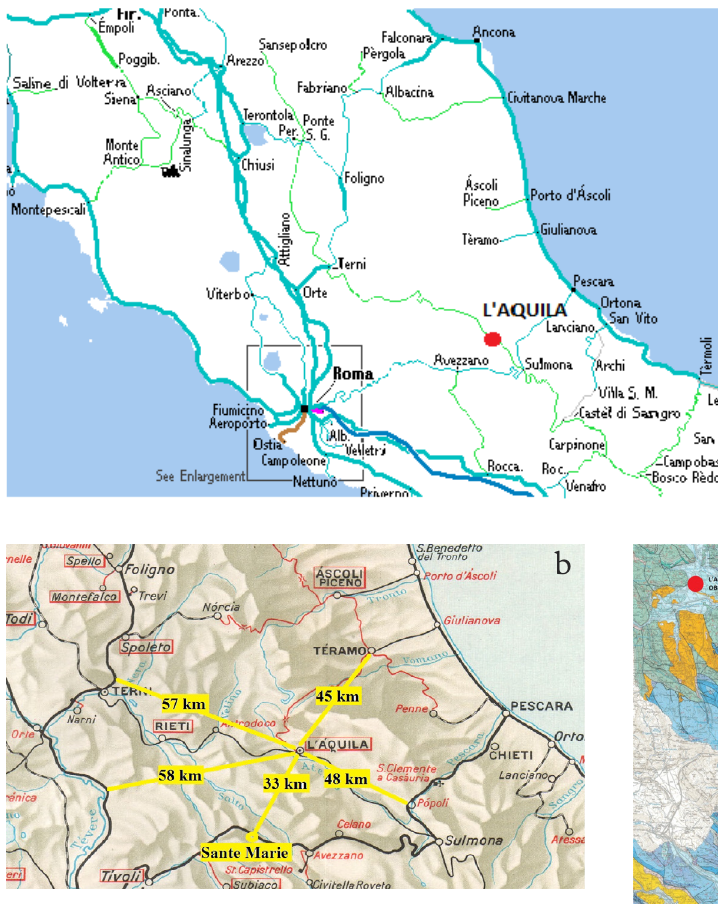
Figure 3. (a) Railway map of Central Italy. The DC electrified rail- way line that mainly interferes with L’Aquila Geomagnetic Obser- vatory is Roma-Sulmona-Pescara in light blue colour; at the contrary the Terni-L’Aquila-Sulmona line, in green, it does not dis- turb the magnetometers because is not electrified (diesel power). (b). Minimum distances of L’Aquila Geomagnetic Observatory from the nearest DC electrified railways (Sante Marie station is the nearest one at 33 km). The railway line that contributes most to the noise at L’Aquila observatory is that from Sante Marie to Popoli, in particular from Avezzano to Pescina in the flat Fucino (Marsica site) due to the high electrical conductivity of lacustrine sediments and clay deposits in the subsoil; in fact the wide basin of Fucino until 1875 was a lake, the third largest of Italy. (c). Geological map of Abruzzo [Vezzani and Ghisetti 1996]: the position of L’Aquila observatory is indicated in the upper left by the red point. In the bottom center the position of Fucino is represented by light blue color and with similar color the Peligna Valley in the lower